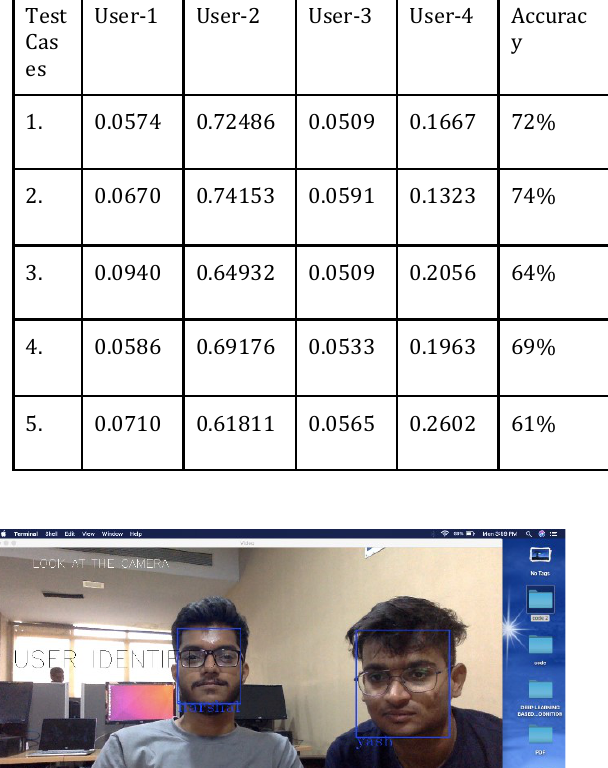
Table 1. Results for Facial recognition of User-2 with Glasses.